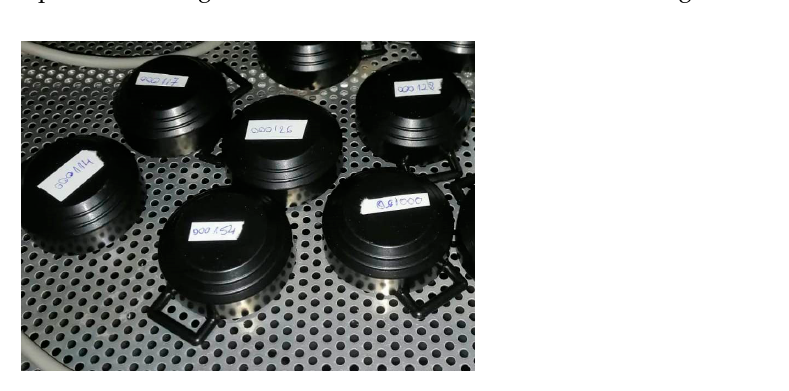
Table 1. The range of the alpha-particles following the 222 Rn decay, in air and in a TASTRAK detector. Radionuclide Alpha-Particle Energy Range in Air Range in TASTRAK (MeV) (cm) ( μ m) 222 Rn 5.5 4.0 33 218 Po 6.0 4.9 40 214 Po 7.7 7.0 58